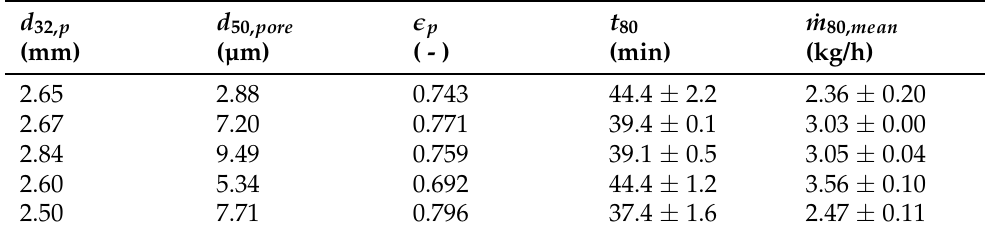
Table 2. Drying time and mean evaporation rate of coffee granules as a function of Sauter mean diameter d 32, p of the particle size distribution and structural parameters such as mean pore size d 50, pore and open porosity (cid:101) .